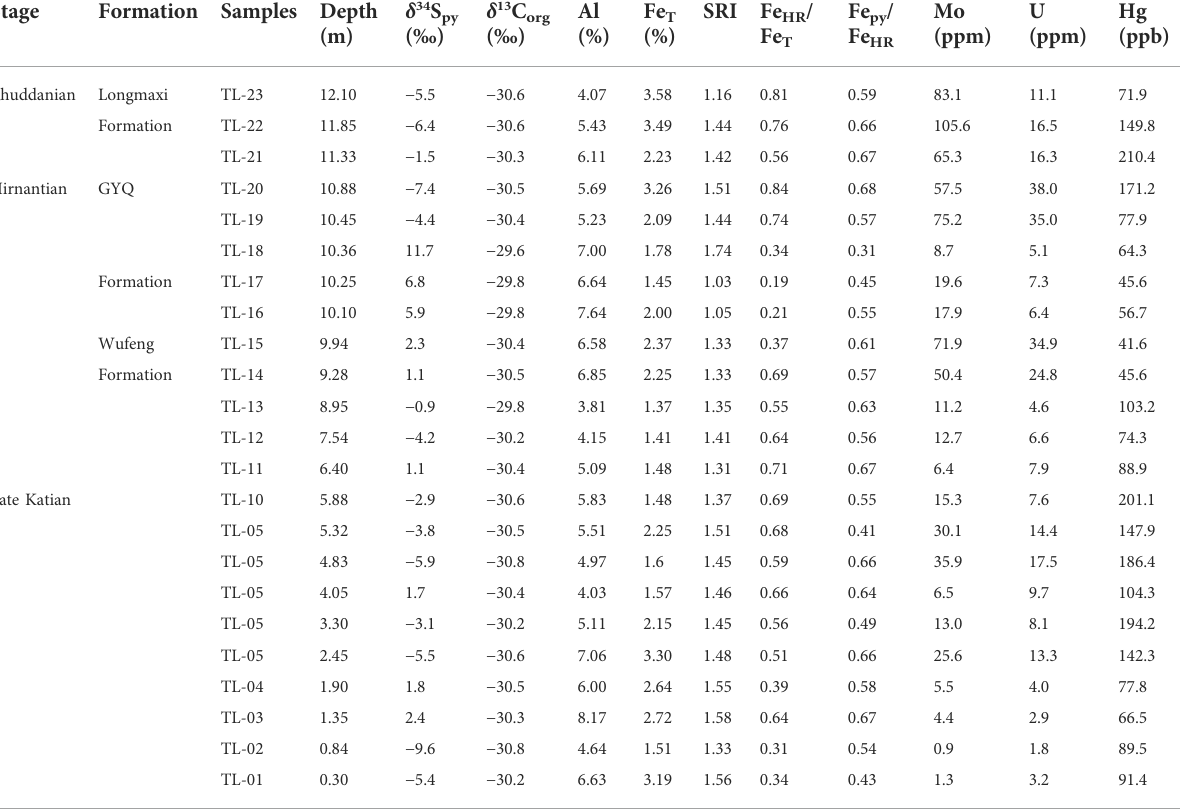
TABLE 1 Results of the major, trace elements, δ 13 C org and δ 34 S py in the Tianlin section.